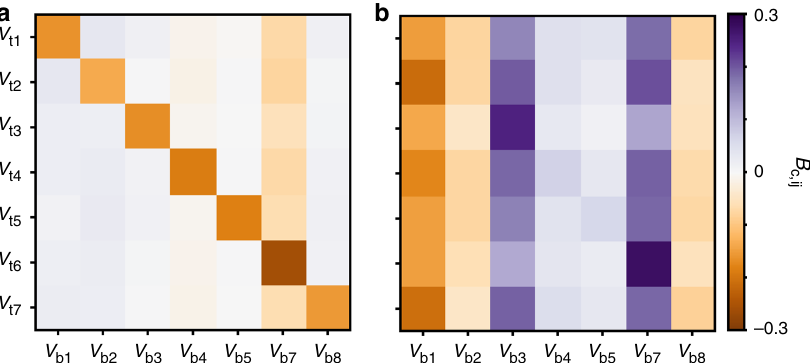
Fig. 7 Learning about device variability. B c matrices obtained using point set registration. Indices are the gate voltage locations v b and v t . V 6 = 0 mV was fi xed in Device 2 to prevent leakage currents. a Transformation between the hypersurface of Device 2 before and after a thermal cycle. b Transformation between the hyperfsurfaces of Device 1 and Device